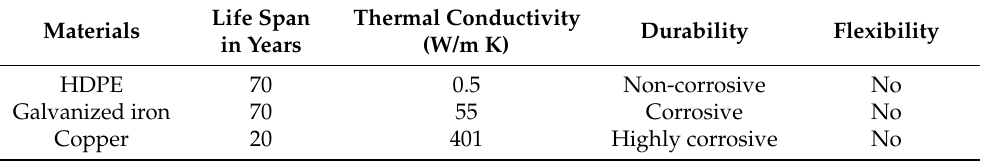
Table 3. Comparison of available pipe materials in Karachi, Pakistan [33,52]. Materials